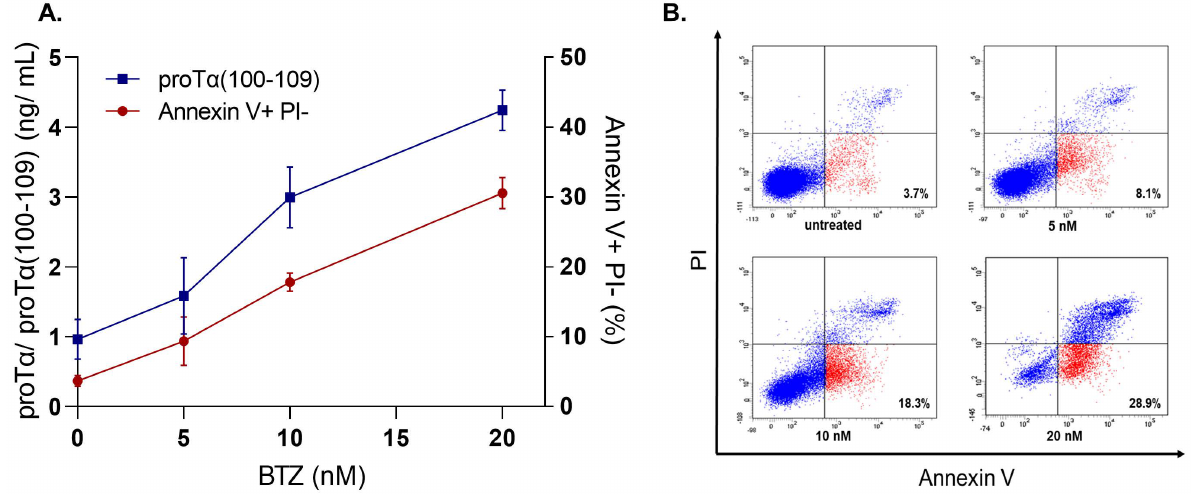
Figure 4. The levels of proT α (100–109) correlate with the percentages of early apoptotic H929 human myeloma cells treated with bortezomib (BTZ). ( A ) An overlay chart, showing the concentration of the peptide as determined in H929 culture supernatants (left axis) versus the percentages of early apoptotic (Annexin V+ PI − ) H929 cells (right axis). H929 cells were treated with BTZ (5, 10, and 20 nM) for 72 h at a cell density of 1 × 10 6 cells/mL. Values are means ± SD from three individual experiments performed. ( B ) Representative dot plots from one experiment with H929 cells treated with BTZ. Other details are as in the legend of Figure